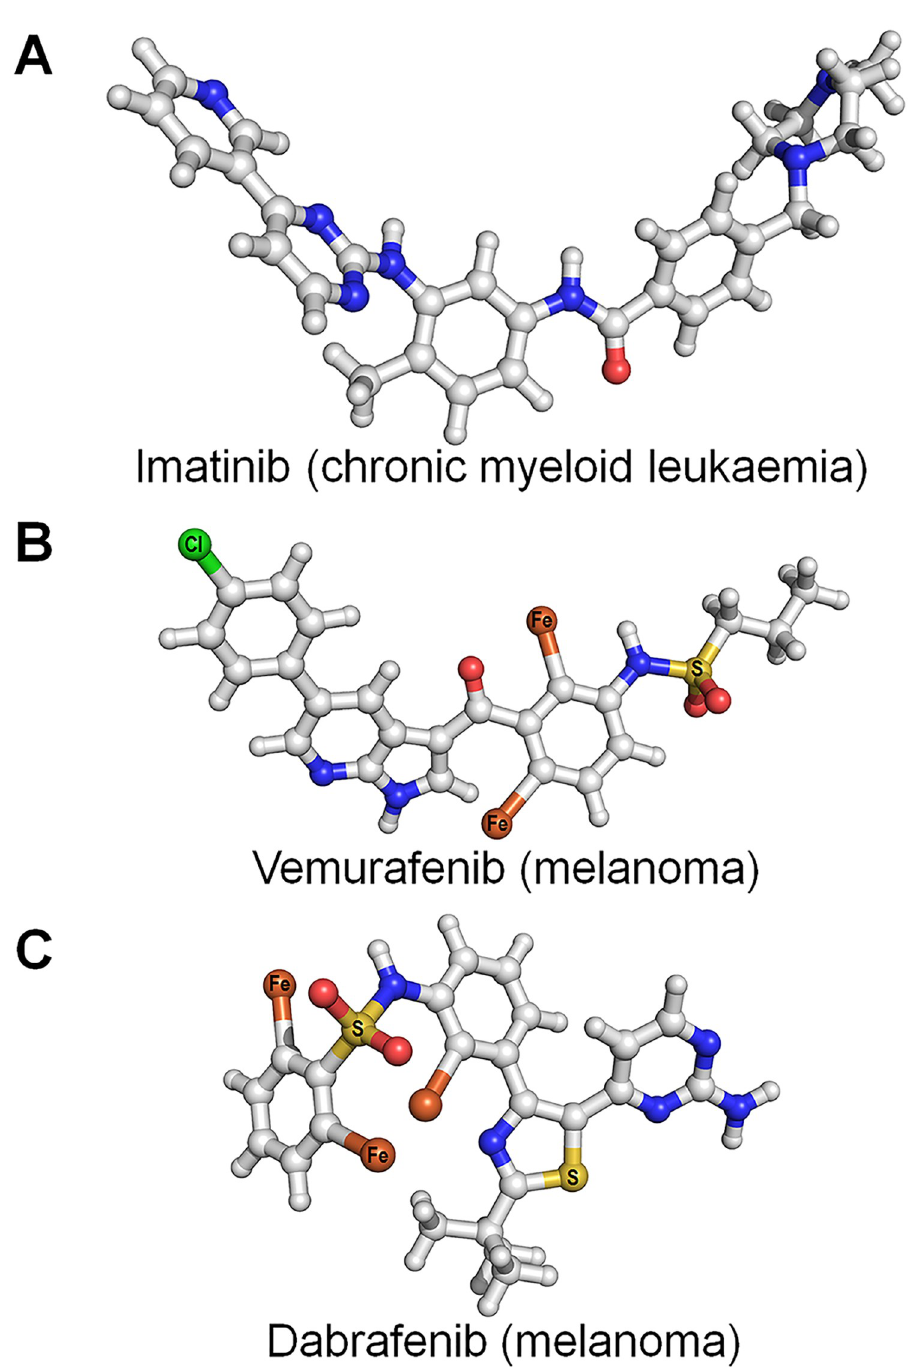
Fig 2. Examples of chemotherapy drugs. Molecular structures of (A) imatinib, (B) vemurafenib, and (C) dabrafenib. Imatinib is used for chronic myelogenous leukemia and acute lymphocytic leukemia. Both vemurafenib and dabrafenib are drugs for the treatment of melanoma targeting the B-Raf V600E mutant. In the structure, C, N, and O atoms are denoted as white, blue, and red spheres, respectively. Hydrogen atom is represented as an edge of stick. Other heavy atoms, S, Cl, and Fe atoms, are marked on the sphere. Molecular topologies with the coordinates are generated by using Avogadro software